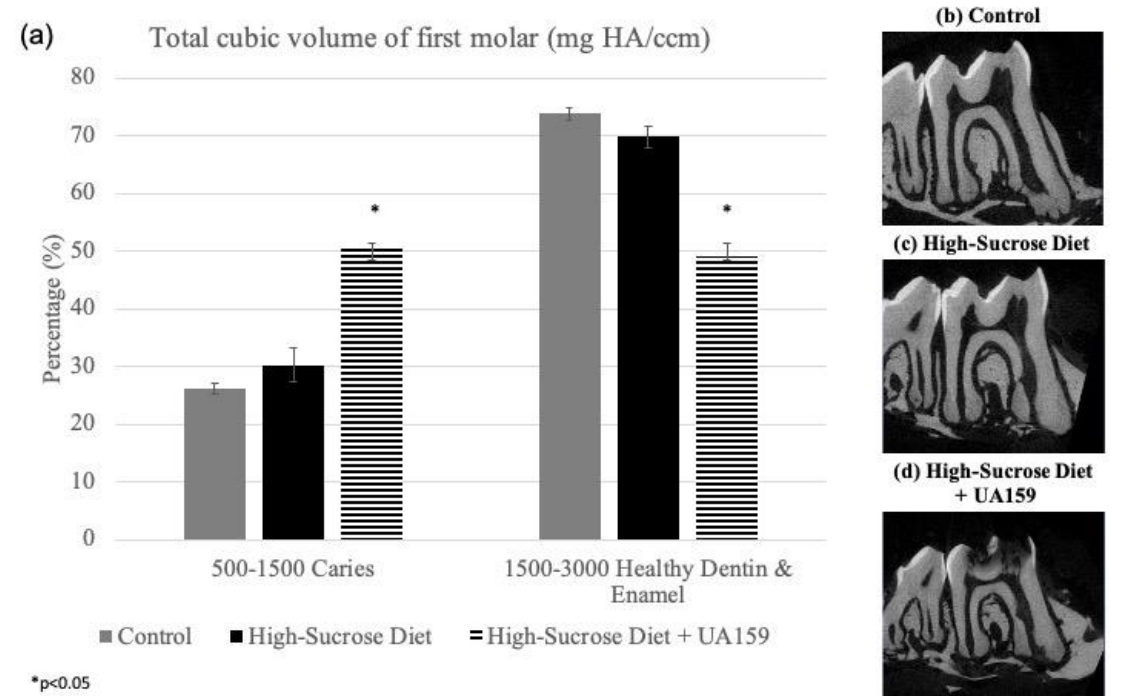
Figure 8. Radiographic µ CT analysis shows carious lesions induced by high-sucrose diet and UA159 S. mutans . µ CT radiographs were analyzed using a dedicated algorithm to divide total crown volume into density ranges. ( a ) Comparison of the volumetric percentage of density ranges by mgHA/ccm (i.e., caries representing range was determined to 500–1500 mgHA/ccm, healthy dentin and enamel representing range was determined to 1500–3000 mgHA/ccm). Mice were divided into three groups: high-sucrose diet (Keyes’ #2000 and 10% sucrose containing distilled water) with UA159 bacterial-infected group (n = 5) (striped column) compared to control (receiving normal diet and distilled water, n = 5) (gray column) and high-sucrose diet (without bacterial infection, n = 5) (black column). Representative radiographic images of the first molar from each group: ( b ) control, ( c ) high-sucrose diet, and ( d ) high-sucrose diet + UA159.